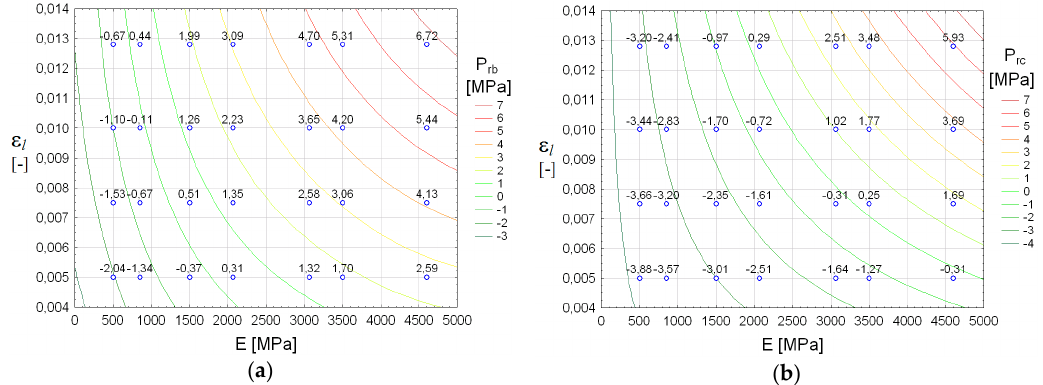
Figure 13. Maps of: ( a ) the rebound pressure P rb ; and ( b ) the recovery pressure P rc , as correlated with E and ε l for the Fruitland Boomer Well B-1 San Juan basin.